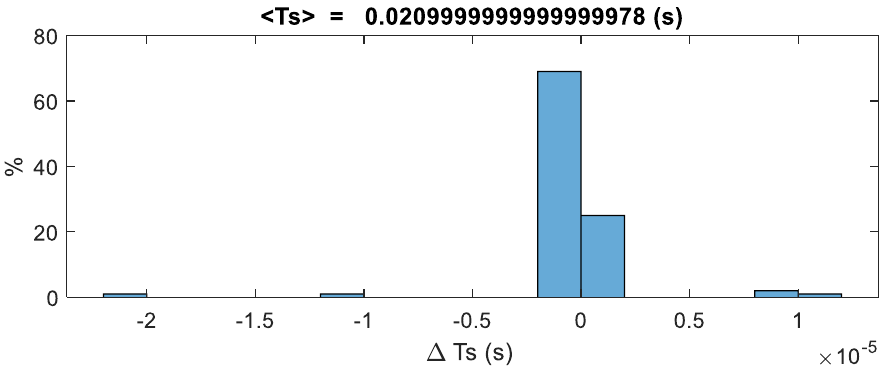
Figure 9. Error distribution of sampling time T s .